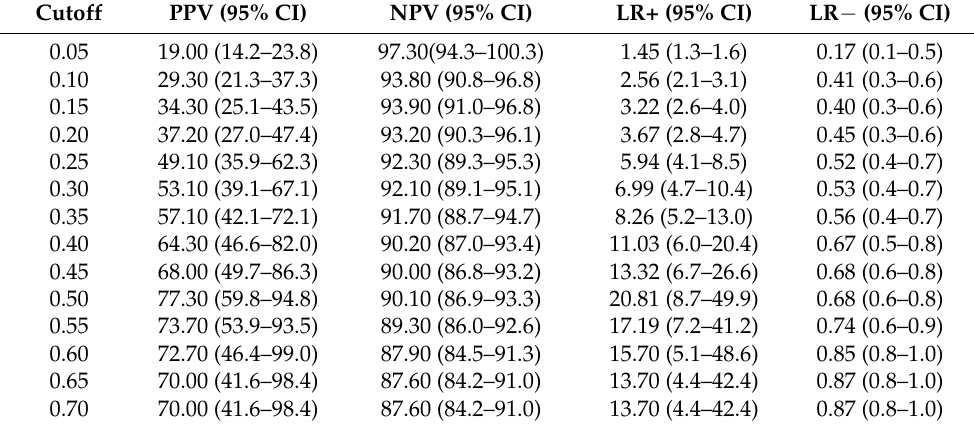
Table 6. Predictive values and likelihood ratios with 95% confidence intervals (CI).